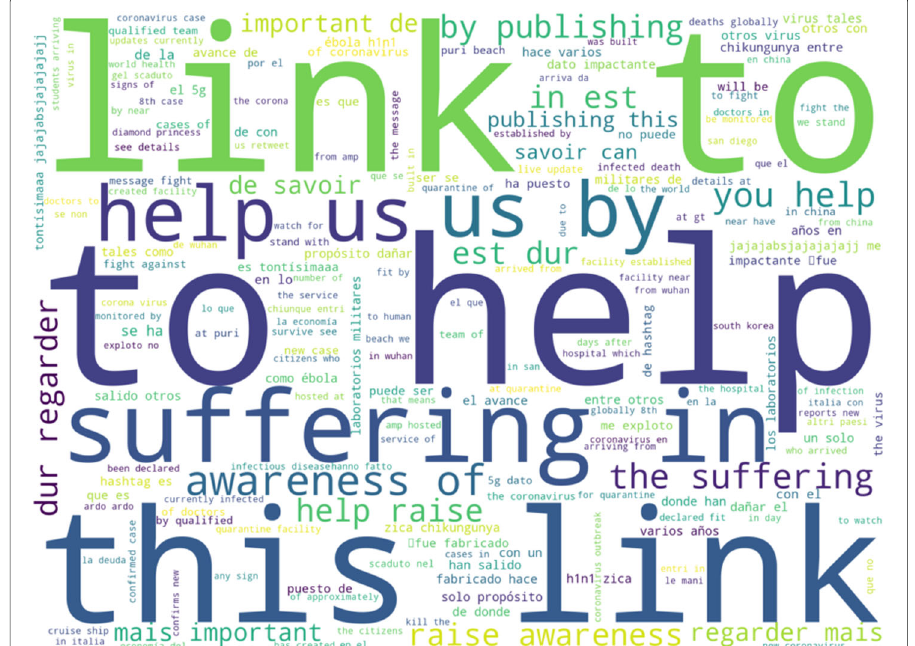
Fig. 12 Word map of commonly occurring phrases and words from period 1, cluster 13. Much of the verbiage seems aimed at directing users to links to support various parties involved in the Syrian Civil